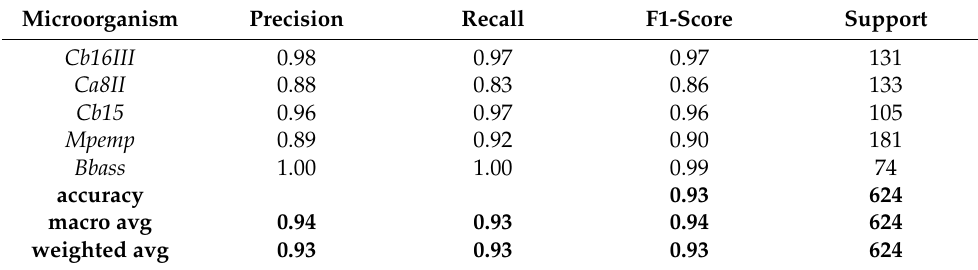
Table 2. Precision, recall, F1 score and support with model 1 for fungal spores.